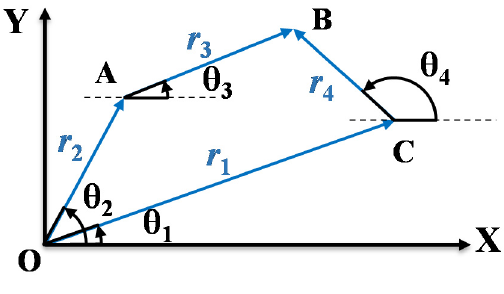
Figure 6. Vector loop of four-bar linkage [10].